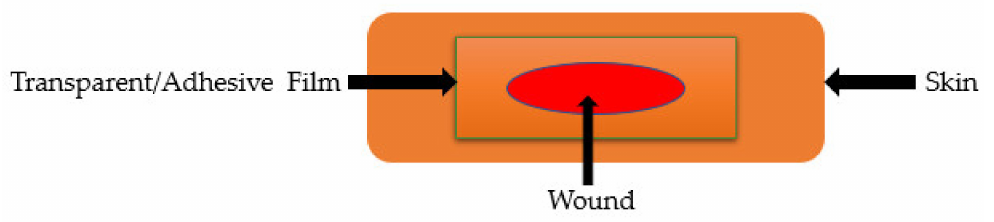
Figure 6. Transparent Film Dressing on Skin